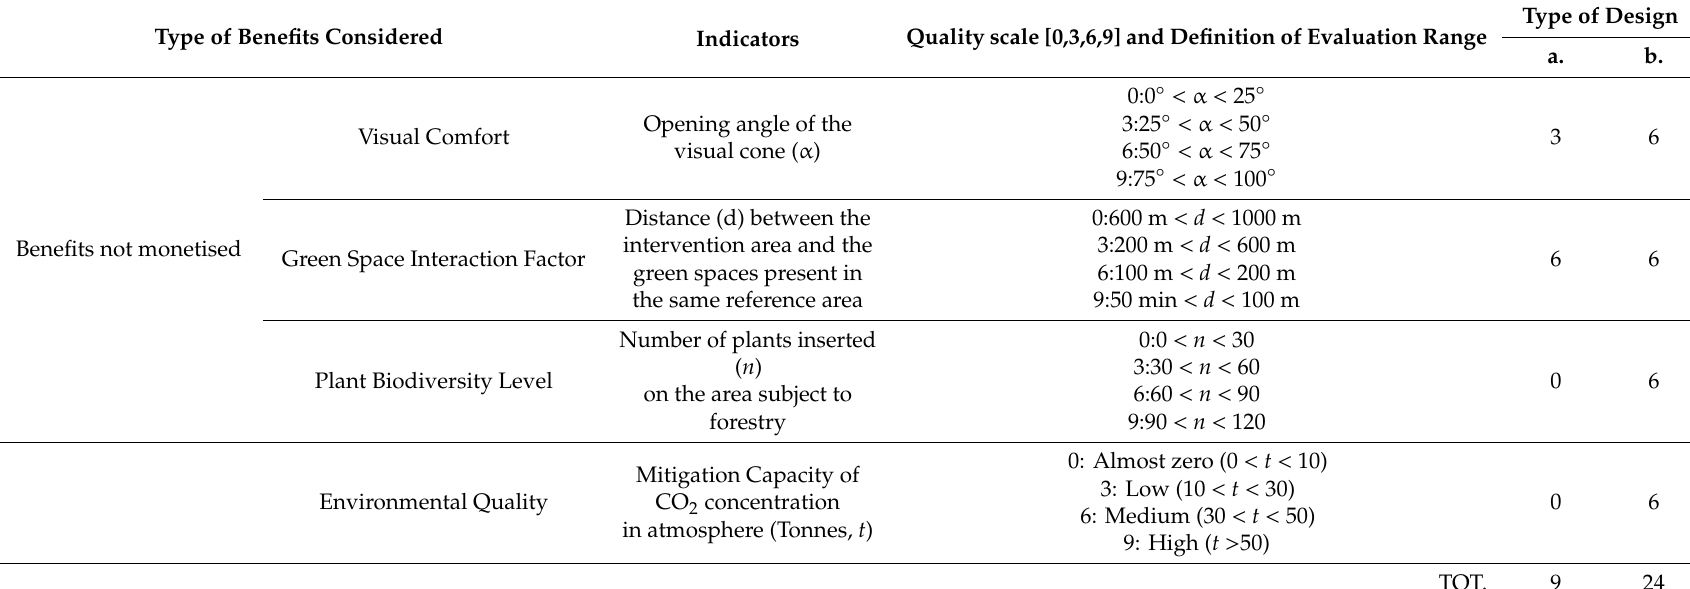
Table 10. Estimation of the benefits not monetised in the case of both integrated and non-monetary ecosystem